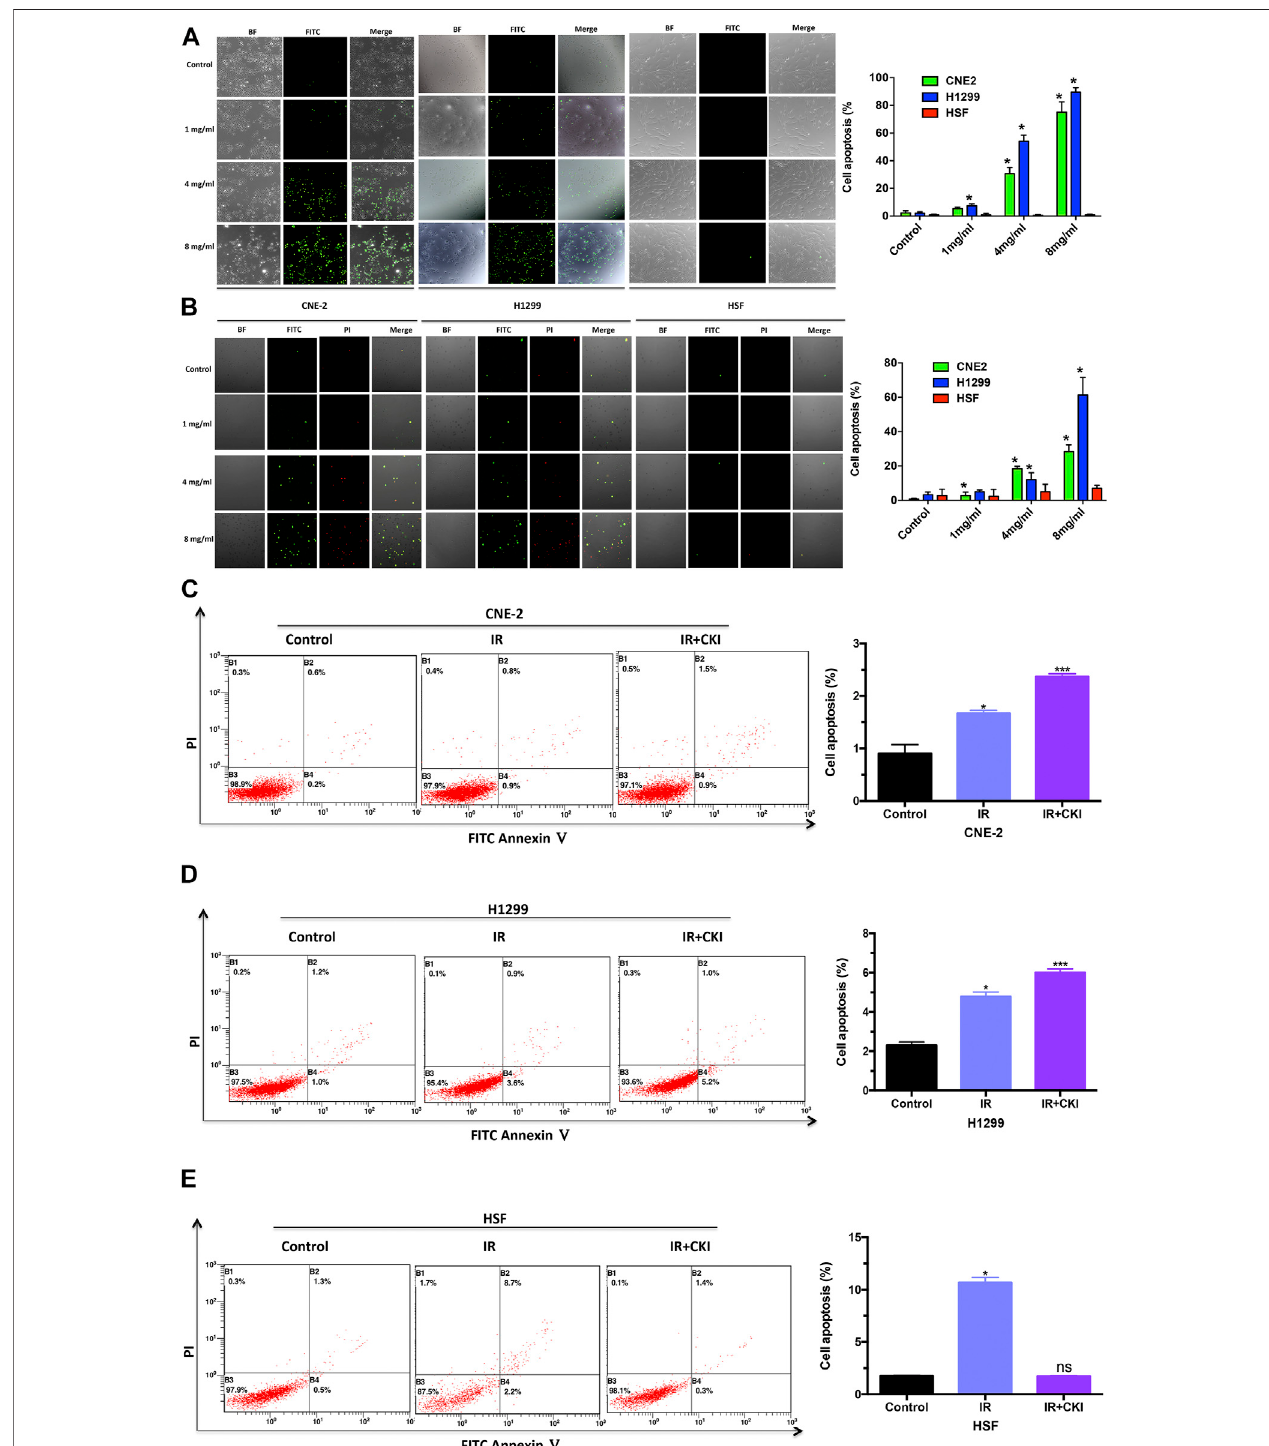
FIGURE 4 | CKI enhanced cancer cell apoptosis by IR, while rescued the HSF cell apoptosis when treated with IR. (A) Cancer cells (CNE-2 and H1299) and HSF cells were treated with CKI (0, 1, 4, 8 mg/ml), and cell apoptosis was observed by TUNEL assay. (B) Cancer cells (CNE-2 and H1299) and HSF cells were treated with CKI (0, 1, 4, 8 mg/ml), and cell apoptosis was detected by doing PI and FITC annexin-V double staining using confocal microscope. (C – E) Cancer cells (CNE-2 and H1299) and HSF cells were treated with IR (4Gy) and CKI (4 mg/ml) combinedwithIR. Afterwards, cellapoptosis wasanalyzedusing fl owcytometry. Values in bar graphs were given as the mean ± SD from three independent experiments performed in triplicate. *Indicates signi fi cant difference as compared to the untreated control group (* p < 0.05; ***, p < 0.001). ns, not signi fi cant, indicates no signi fi cant difference as compared to the untreated control group.